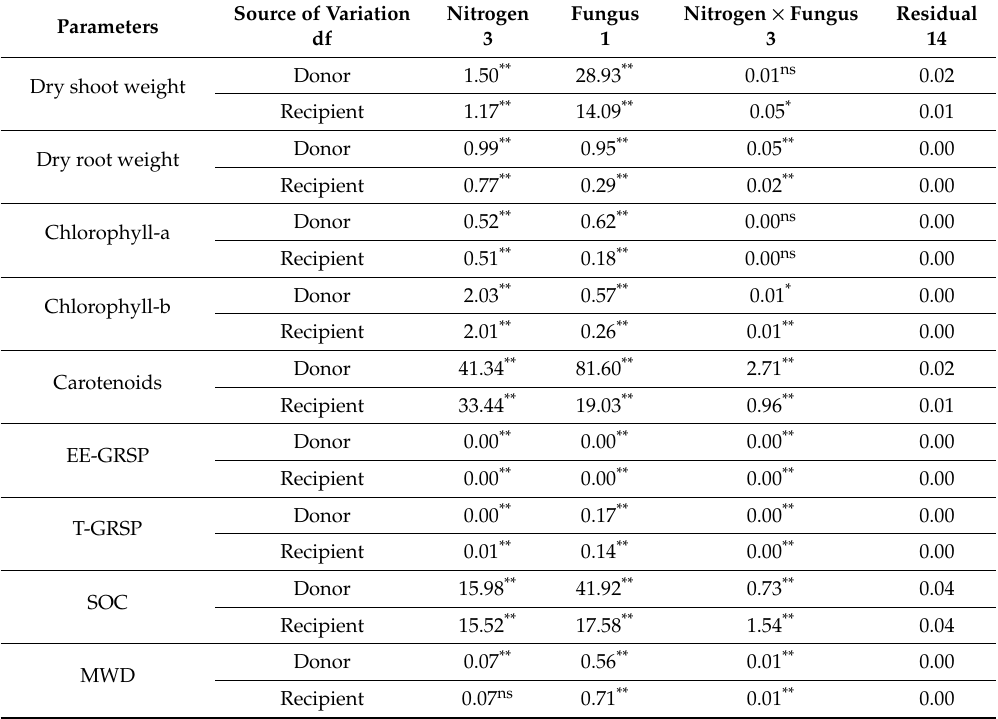
Table 1. Mean squares of absolute values for various traits under mycorrhizal and non-mycorrhizal treatment and significance of main treatment effects (N and Fungus) and their interaction effects (N × Fungus) based on two-way ANOVA. *, **and ns indicate the significant di ff erences at p ≤ 0.05, p ≤ 0.01, and non-significant ( p ≥ 0.05),